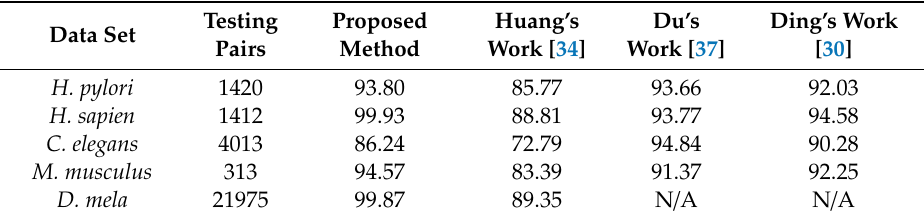
Table 5. Comparison of the accuracy (%) between di ff erent methods on the independent data sets using yeast data set as the training data set.